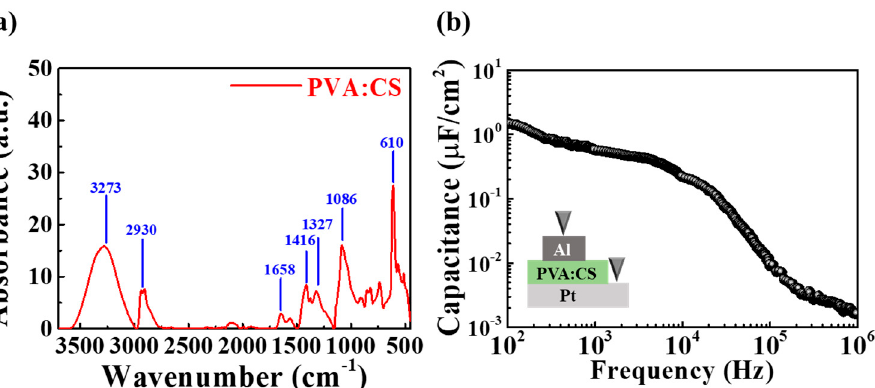
Figure 2. ( a ) FTIR spectra of PVA:CS blended electrolyte films. ( b ) Frequency–dependent capacitance (C– f ) curve of Al /PVA:CS blended electrolyte-based EDL/Pt-structured capacitors.